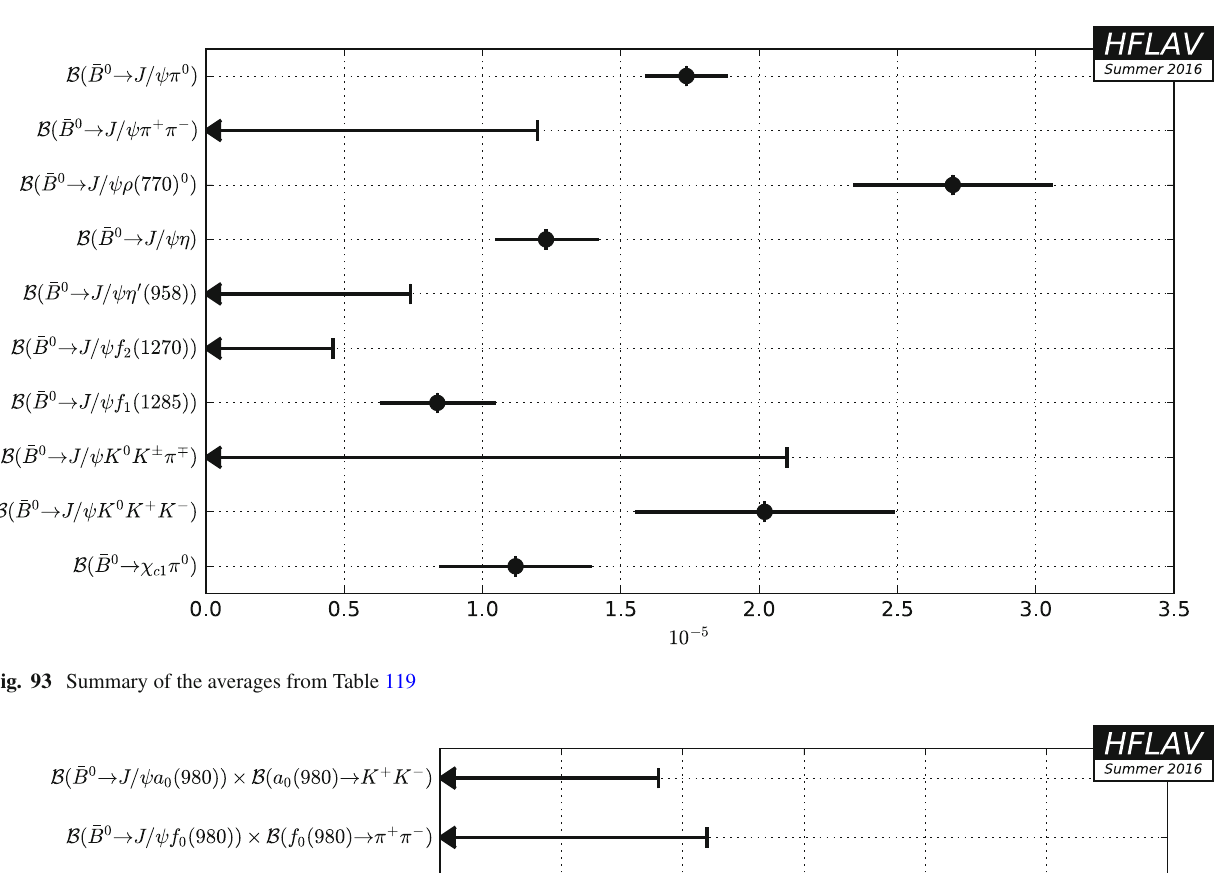
Fig. 92 Summary of the averages from Table 118